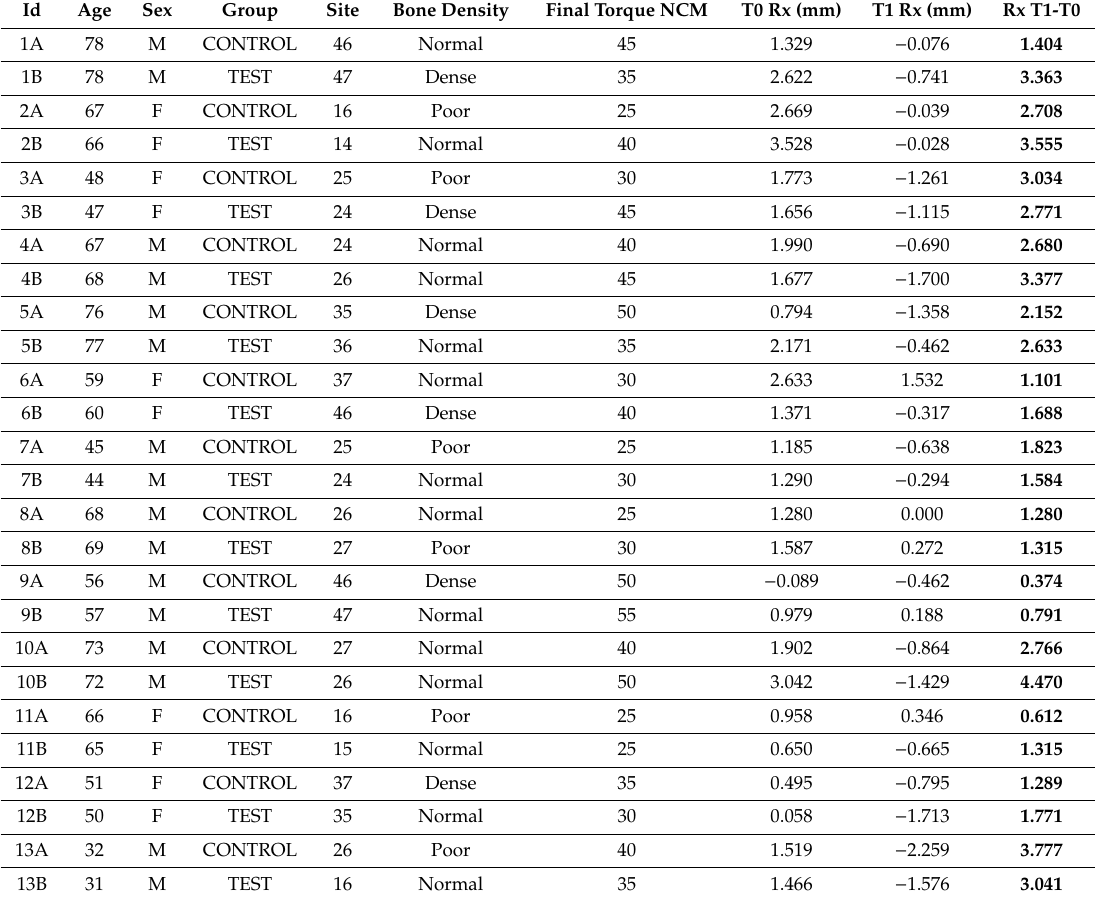
Table 1. Table shows demographic characteristics, site, bone density, insertion torque and radiographic MBL measurements at different time points of all the patients enrolled in the study. The minus ( − ) indicates that the quantity of bone was lost below the implant shoulder (please see Figure 2). A difference was determined between the values obtained of T1-T0 to have the amount of bone resorption at 4 years follow-up.